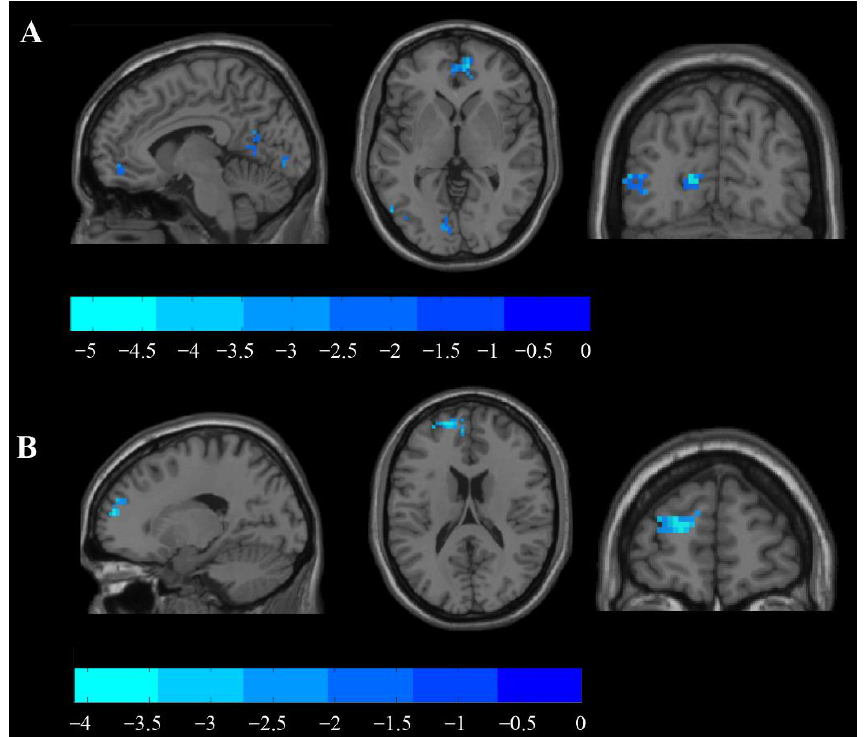
Figure 3. Changes in fALFF as well as FC before and after iTBS intervention: ( A ) differences in fALFF between TP1 and TP2 (paired t -test, p < 0.05, AlphaSim correction, cluster size ≥ 56 voxels) ; ( B ) differences in FC with left precentral gyrus ( − 36, 57,18) between TP1 and TP2 (paired t -test, p < 0.05, AlphaSim correction, cluster size ≥ 129 voxels). The blue concentration represents the degree of decreased regional fALFF or FC values. AAL: automated anatomical labeling atlas, BA: Brodmann area, R: right, L: left.